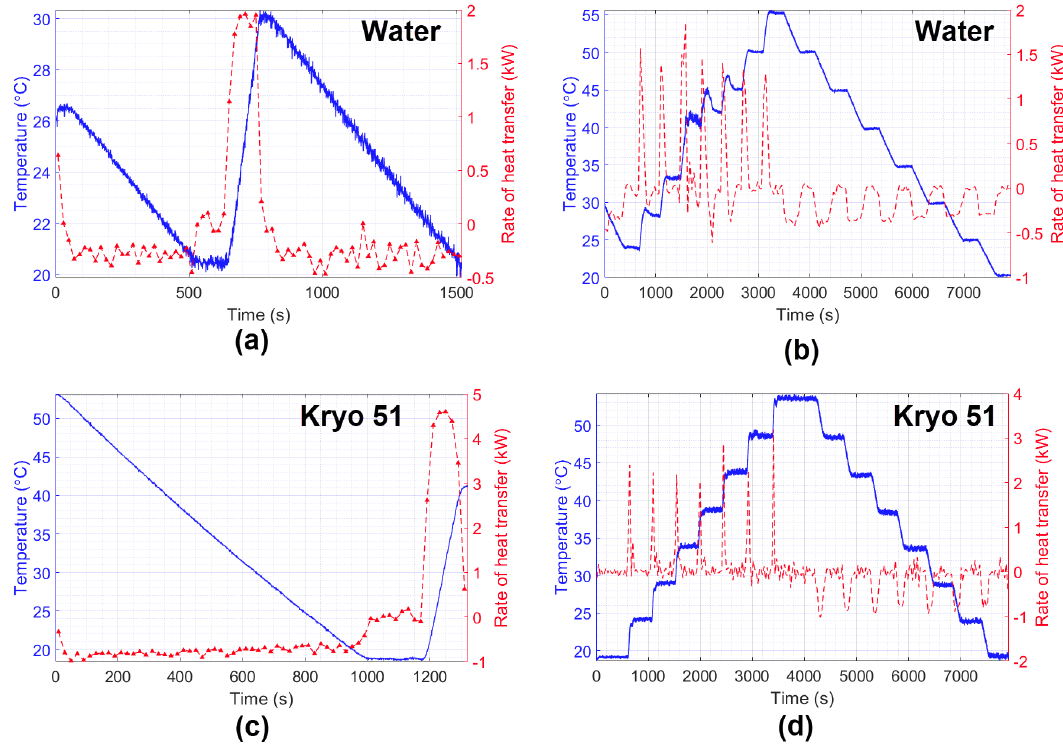
Figure 10. Estimation of the heat transfer rate of water ( a , b ) and Kryo 51 oil ( c , d